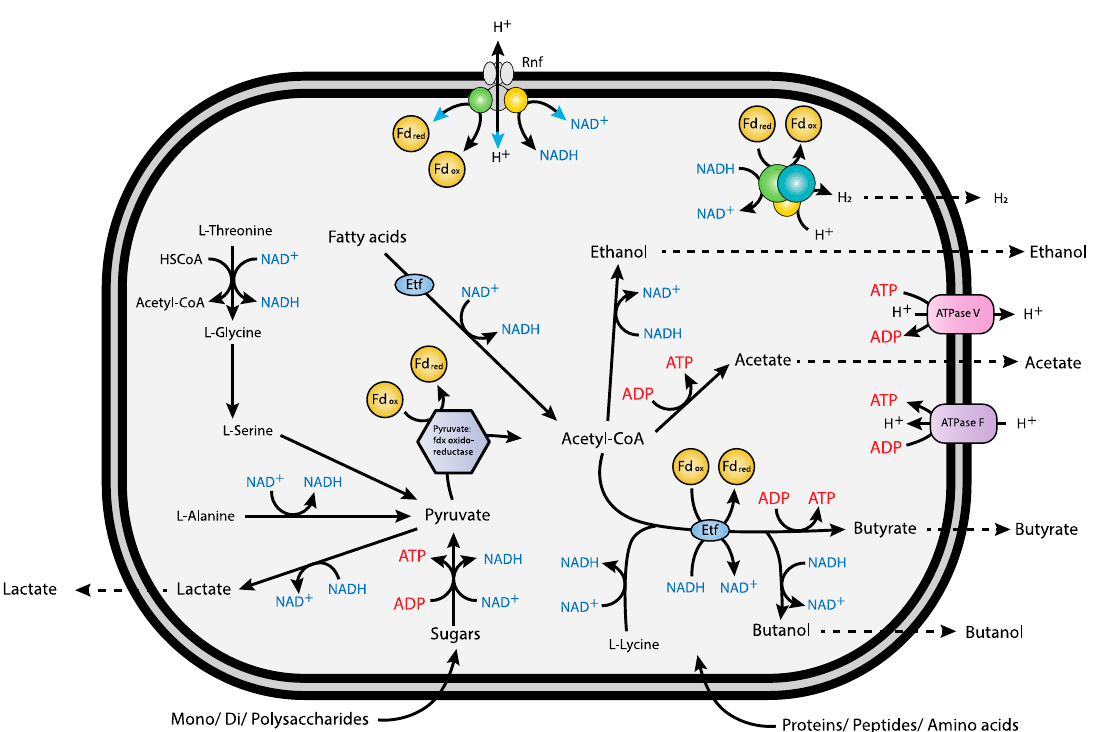
Figure 3. Overview of the main metabolic pathways and energy production in V. guaymasensis L81. The overall scheme for energy conservation in V. guaymasensis L81 is simple. Proton gradient generation is probably done by Rnf mediated Fd red oxidation. In the absence of a terminal electron acceptor or corresponding electron transport chains, hydrogen generated by cytoplasmic hydrogenases is probably produced as a non-respiratory, fermentative mechanism. As Fd red is needed for H 2 generation at higher partial pressure, the bifurcating/confurcating [FeFe] hydrogenases may be capable of conserving energy, coupling oxidation of Fd red and NADH [65].